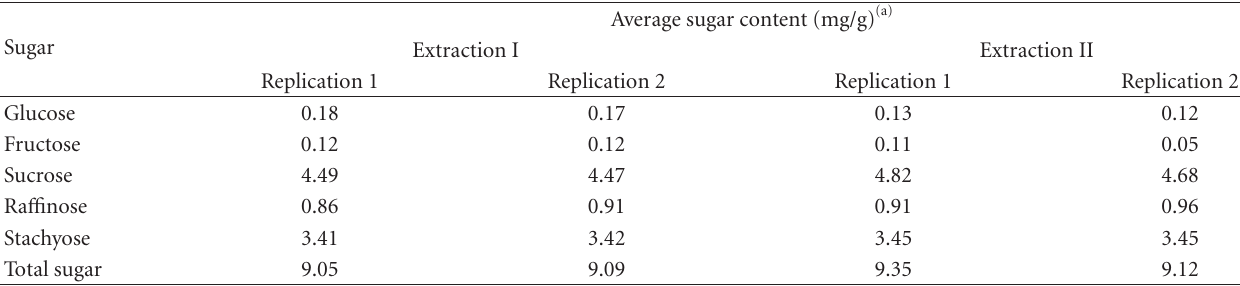
Table 3: Means of individual sugars in 20 soybean genotypes over replications of two duplicate extractions.